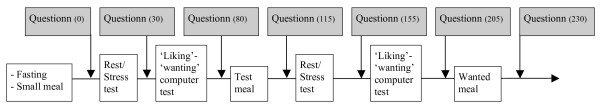
Schematic overview of the study design. Numbers in brackets represent the time points (in minutes) at which data were collected or tasks were completed; 'Question': questionnaires.